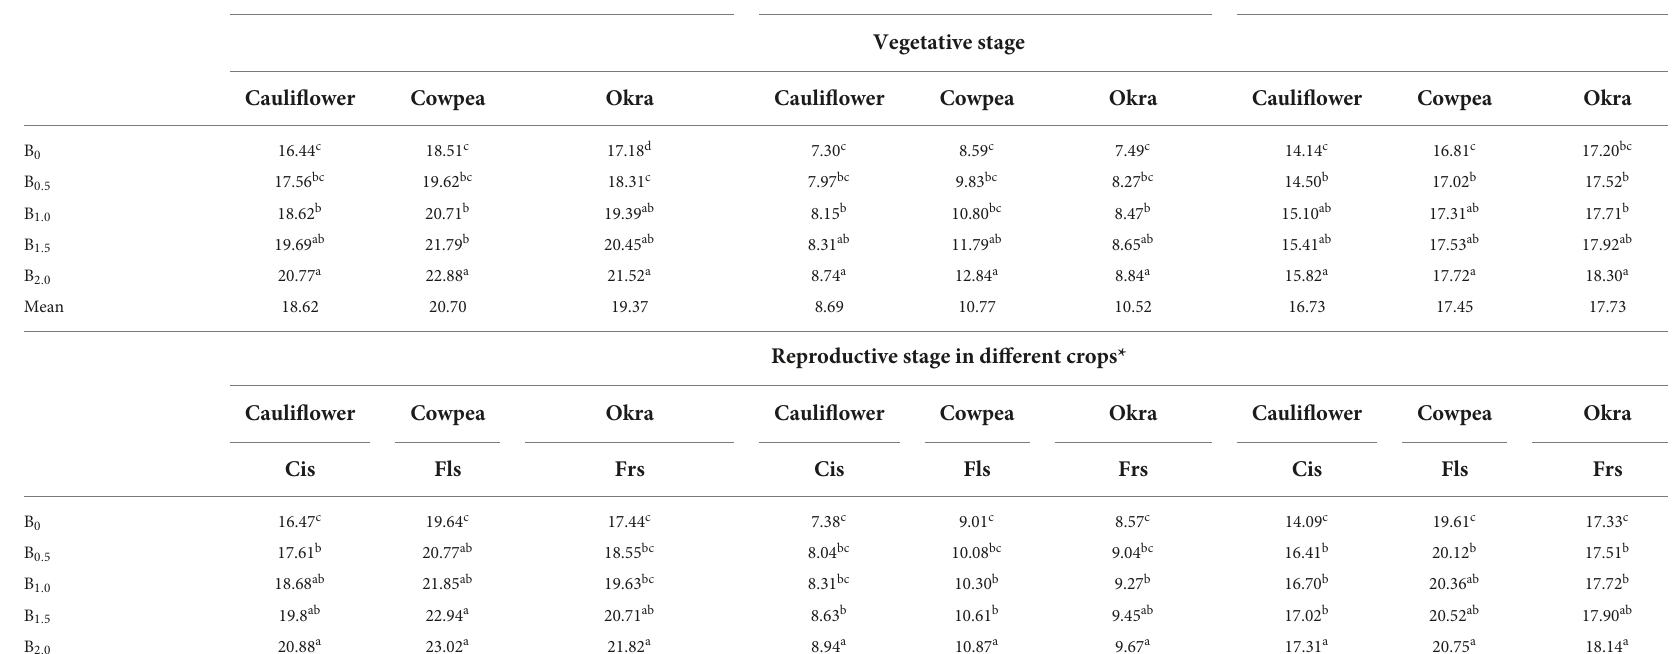
TABLE 4 Effect of graded B levels on microbial populations in soil under cauliflower-cowpea-okra cropping system (Pooled data 2015–2017). B-levels (kg ha − 1